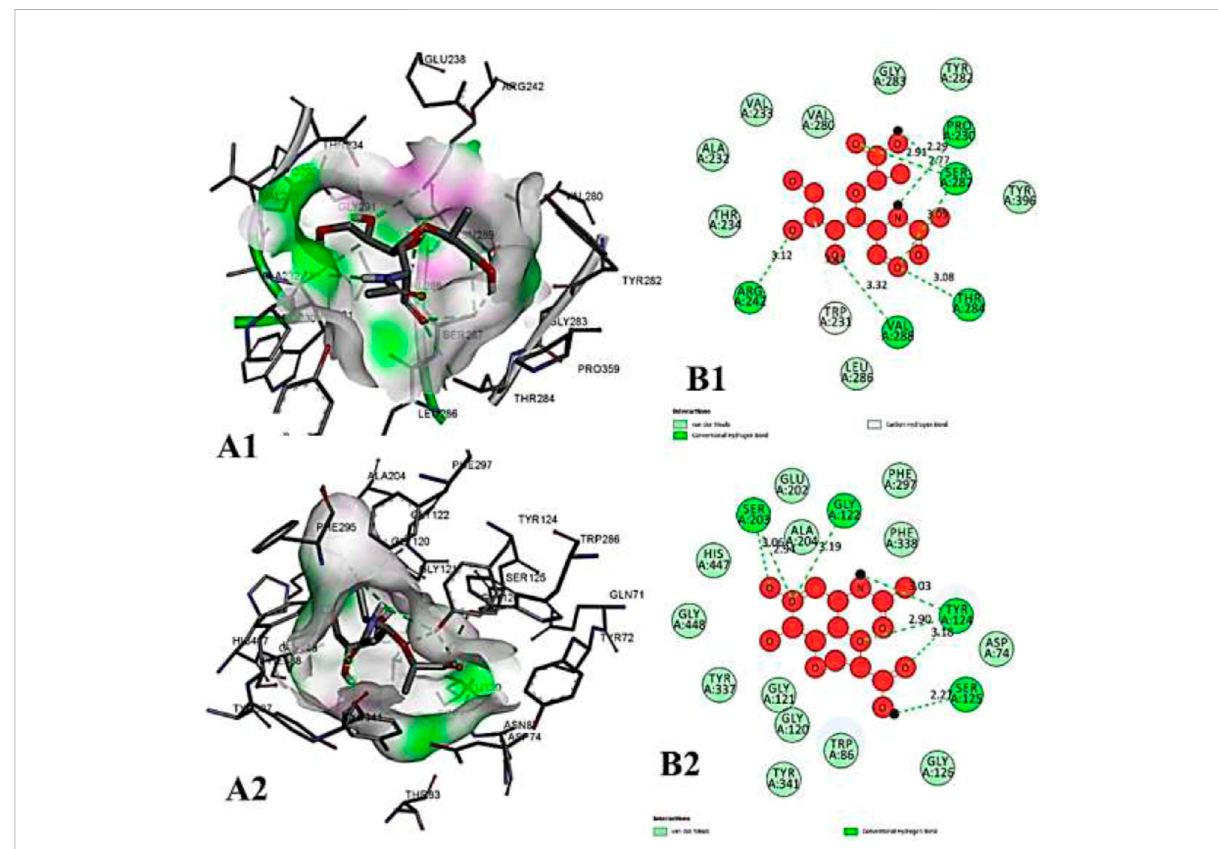
FIGURE 10 Themoleculardockinginteractionsofligand 26,27- diethyl- 1-alpha,25-dihydroxyvitaminD3with (A) 4AQD and (B) 4EY7 receptors in2Dand 3D